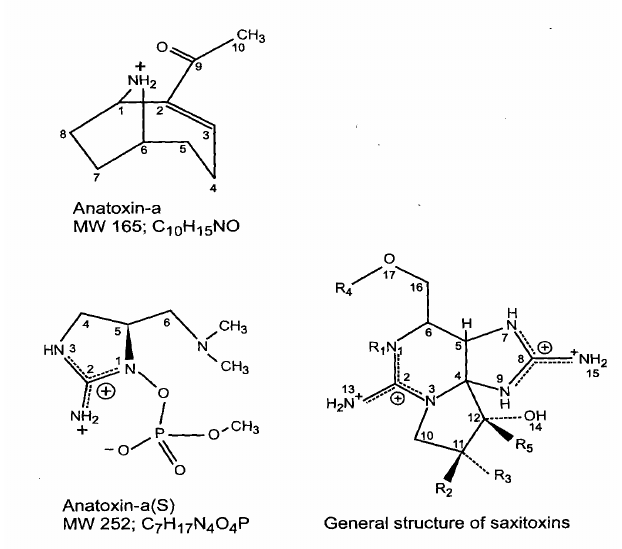
Figure 1: Structures of cyanobacterial neurotoxic